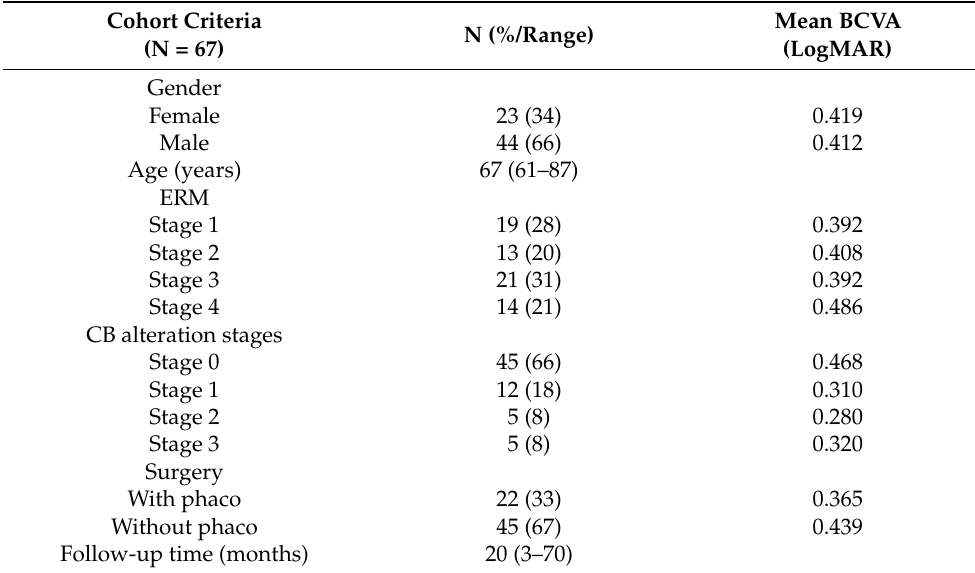
Table 1. Baseline characteristics of study cohort.